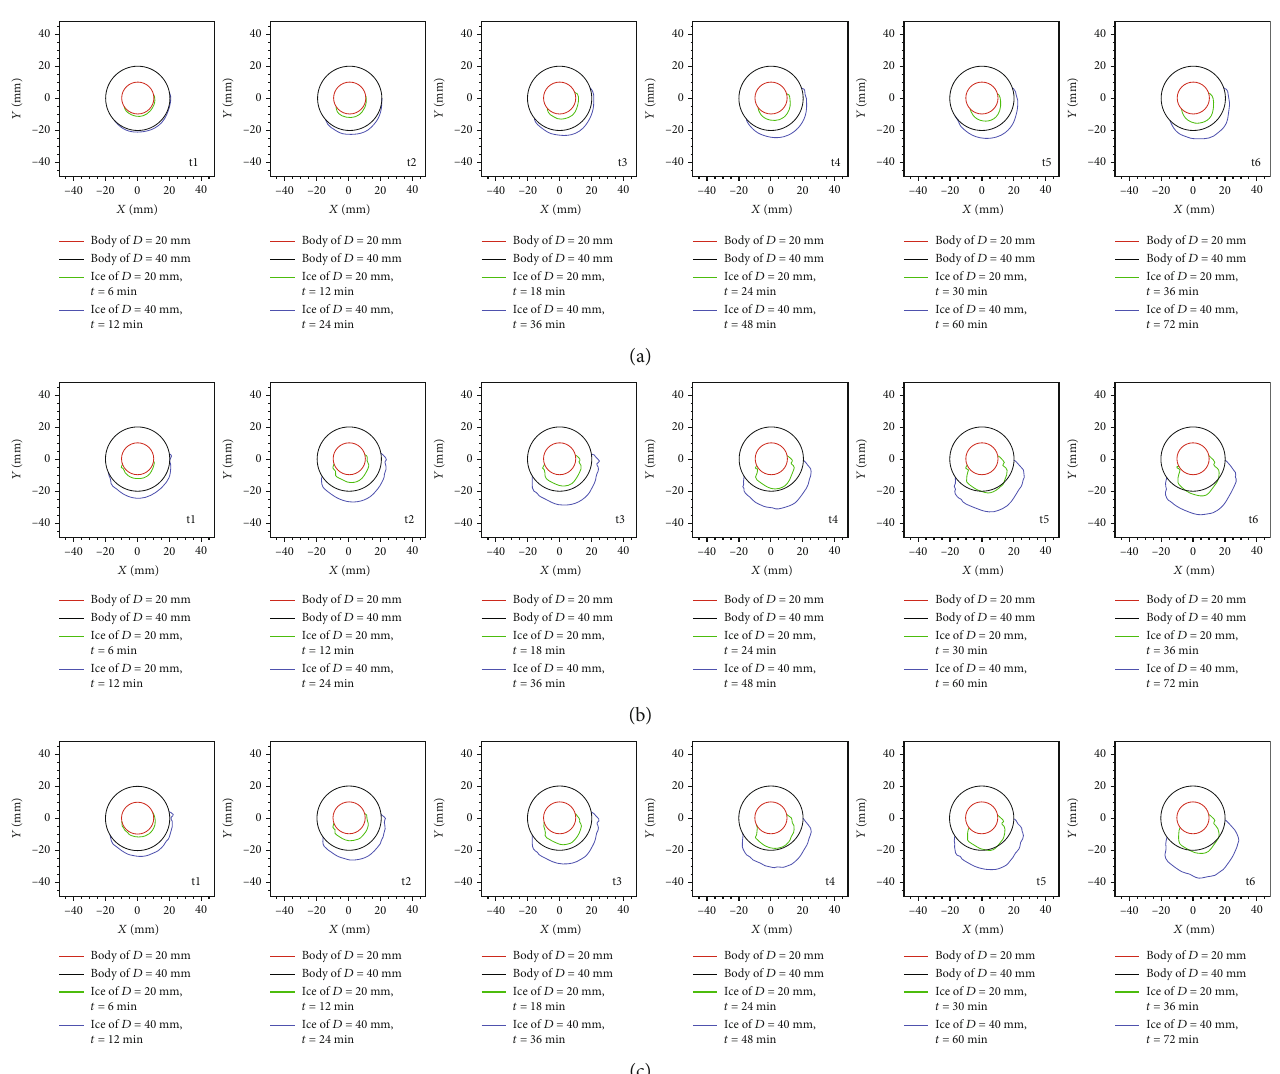
Figure 9: Icing shapes on surfaces of di ff erent sizes of cylinders in the same coordinate system with the same scale: (a) comparison of icing shapes between conditions no. 1 and no. 2; (b) comparison of icing shapes between conditions no. 3 and no. 4; (c) comparison of icing shapes between conditions no. 5 and no. 6.